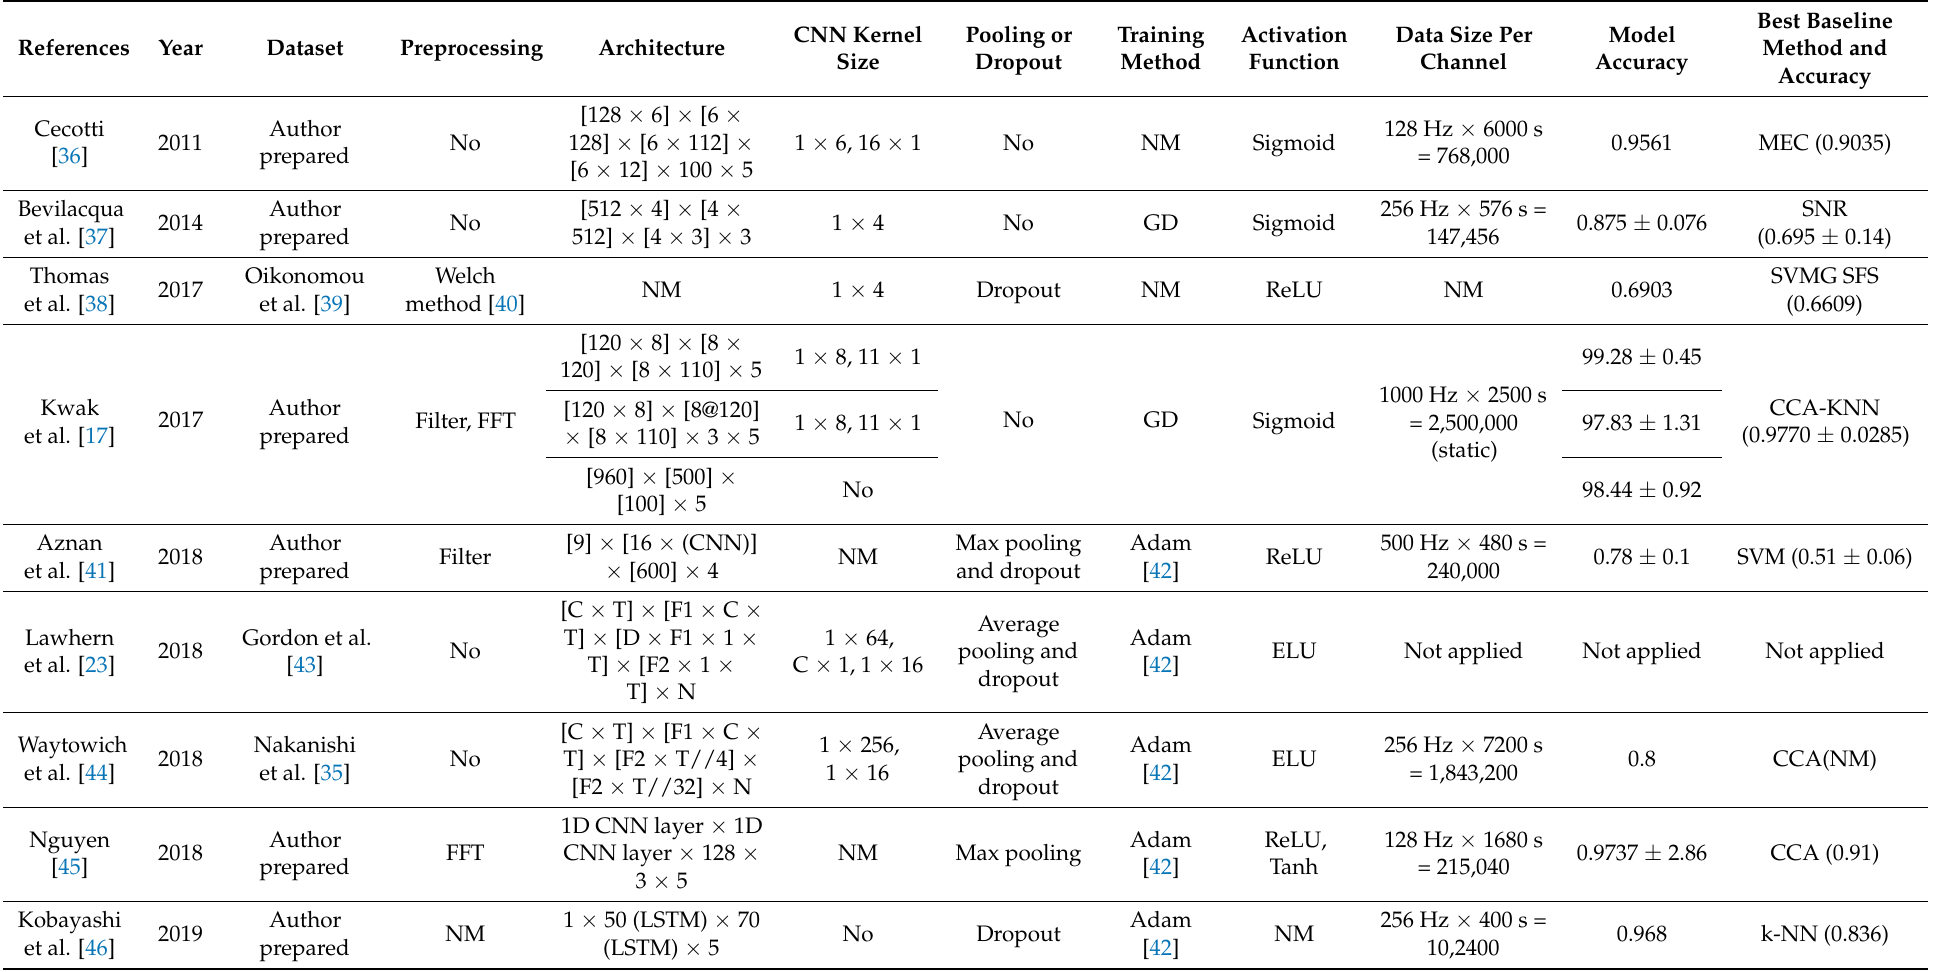
Table 2. A detailed analysis of structures of 31 deep learning models used for SSVEP analysis. NM stands for not mentioned. C is the channel number of the dataset. T is the length of the segment data. GD stands for gradient descent. SGD stands for stochastic gradient descent. ReLU stands for rectified exponential linear unit. Other abbreviations are unique representations in the original paper, so please refer to the